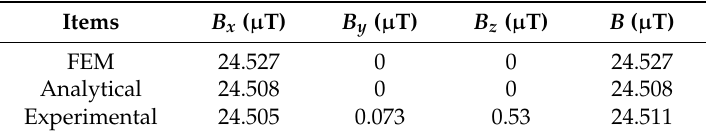
Table 4. Magnetic flux density of the coil at the